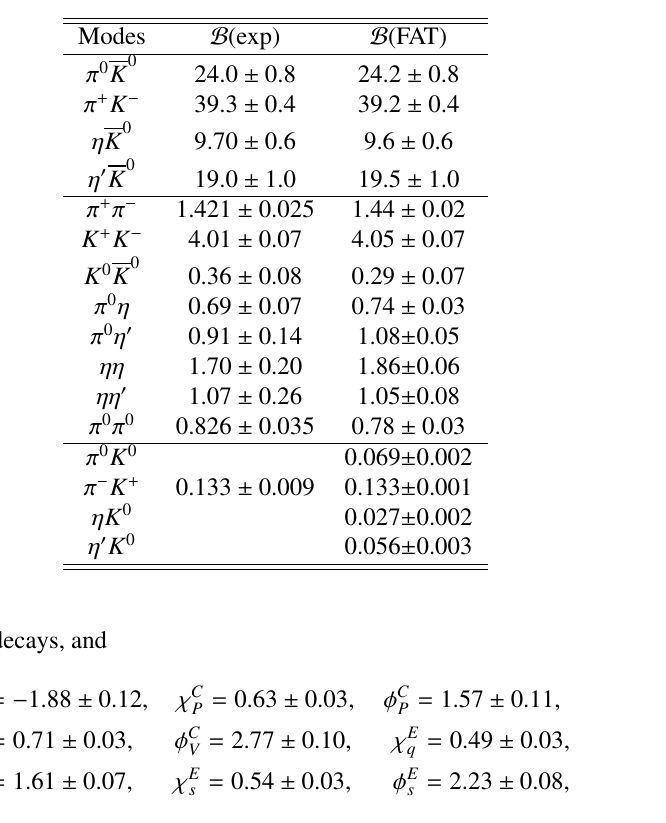
Table 1. Branching ratios in units of 10 − 3 for the D 0 → PP decays. Predictions B (FAT) in the FAT approach are compared with the experimental data B (exp)